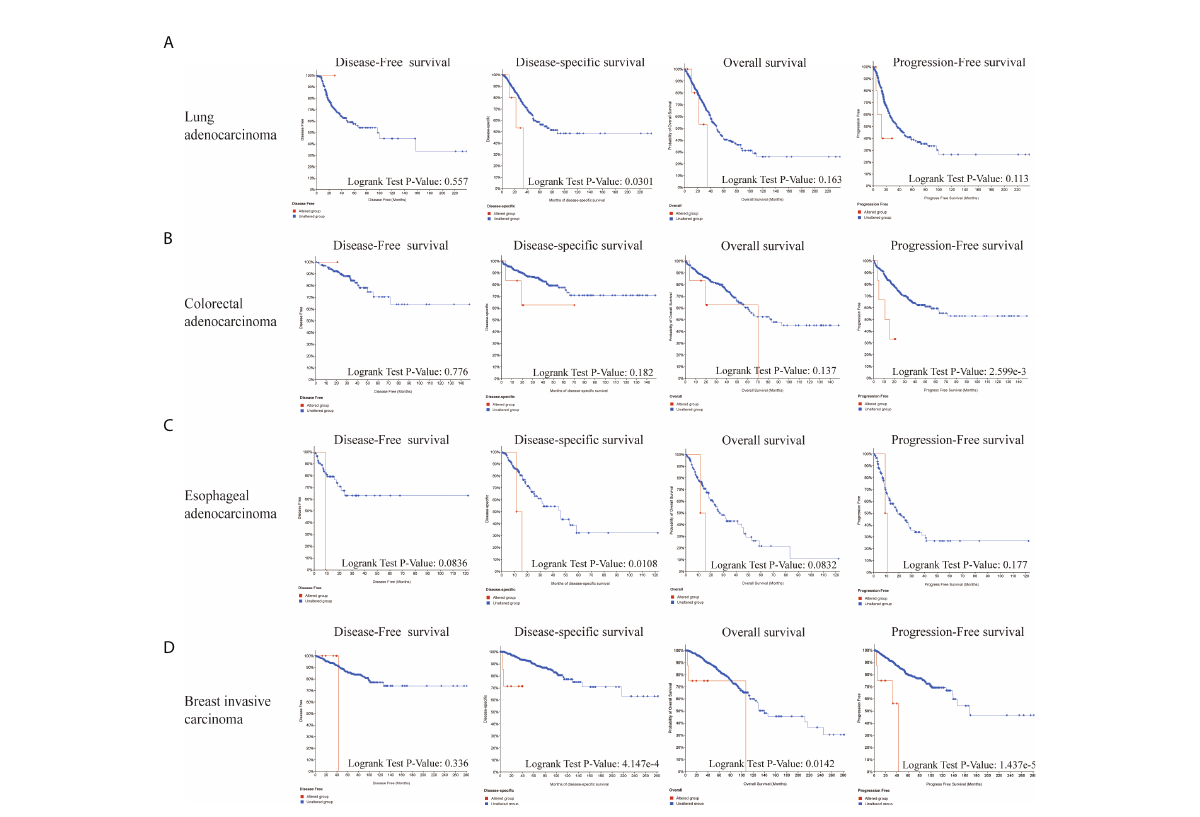
FIGURE 5 The prognosis analysis of LIAS alteration in cancers. (A – D) cBioPortal displayed the relationship between LIAS mutation and prognostic values (DSS, DFS, PFS, and OS) in some cancers, including lung adenocarcinoma, colorectal adenocarcinoma, esophageal adenocarcinoma, and breast invasive cancer.